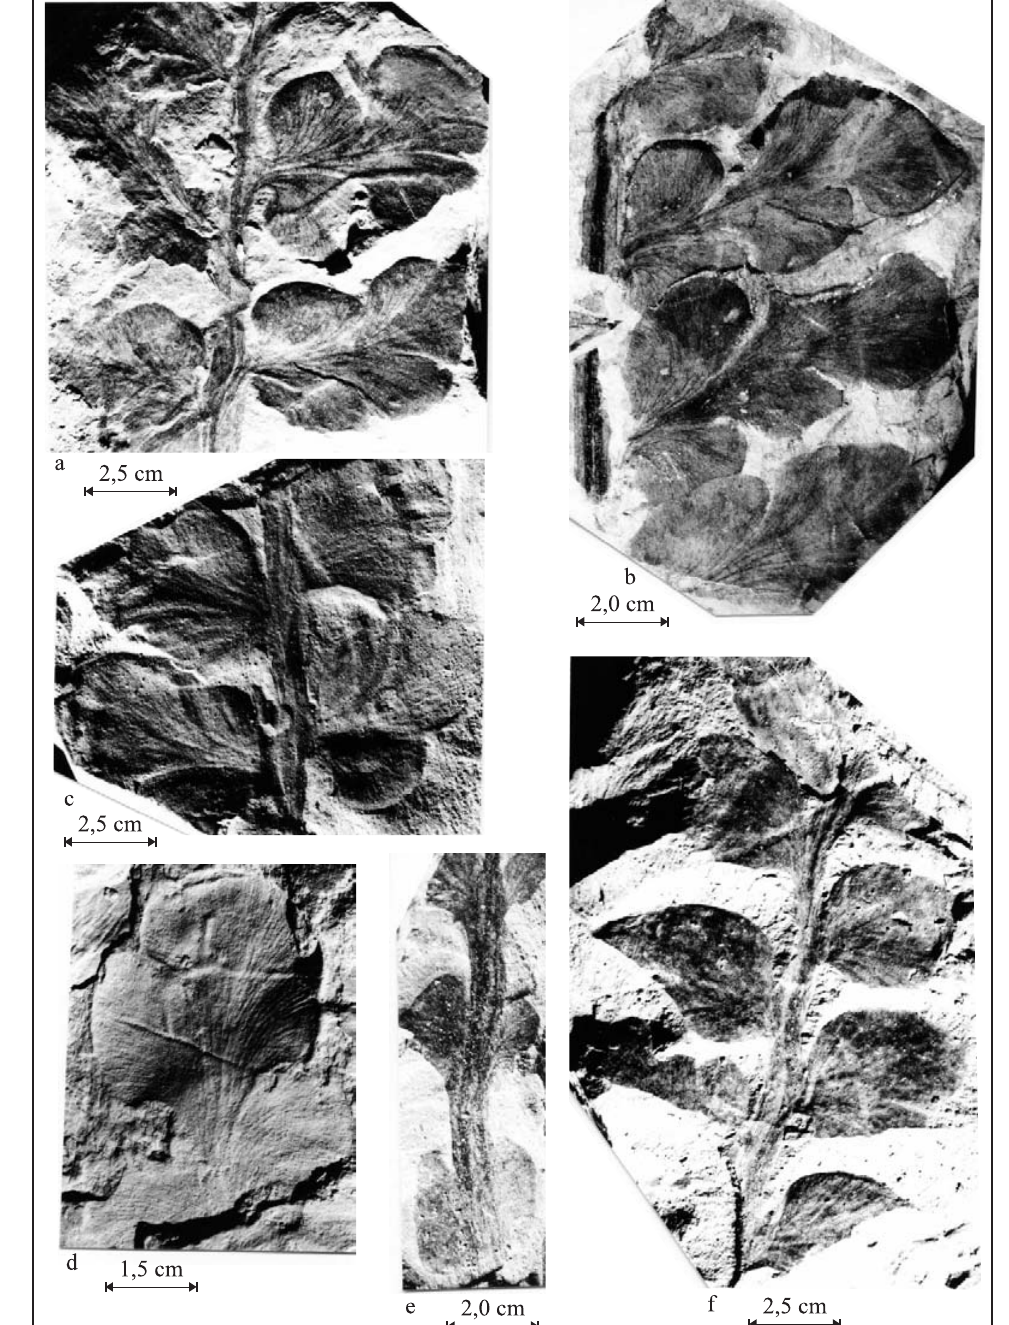
Fig. 3 – Botrychiopsis plantiana fronds from Faxinal and Base of Morro Papaléo: (a) apical portion of the frond with pines whit complete limbus, presenting small insertions and venation - PB 2677; (b) detail from the average portion of a frond – PB 2935; (c) detail from pines and it insertion in the rachis – PB 3009; (d) detail of a pine with venation – PB 3097; (e) basal portion of the frond – PB 2679; (f) basal portion of the frond, representing the morphological differentiation – PB 2499.